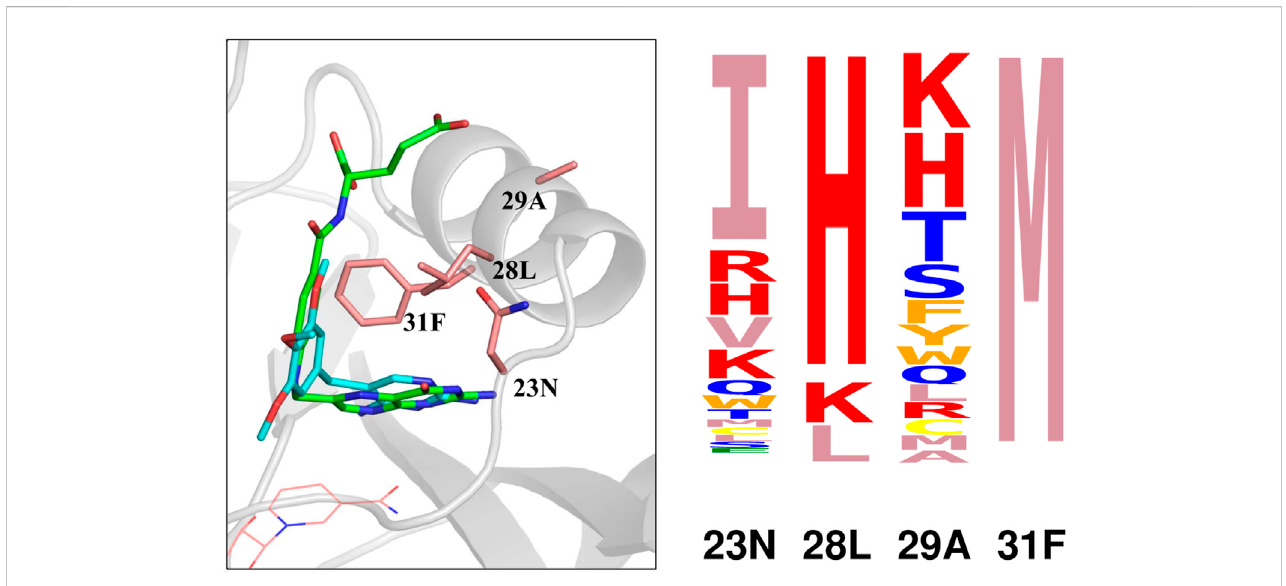
FIGURE 3 (Left) Closeup of four positions (pink sticks) in the DHFR complex with DHF (green sticks) and TMP (blue sticks). NADPH is shown as pink lines. (Right) Vitality logo from singleton redesign of the four positions.